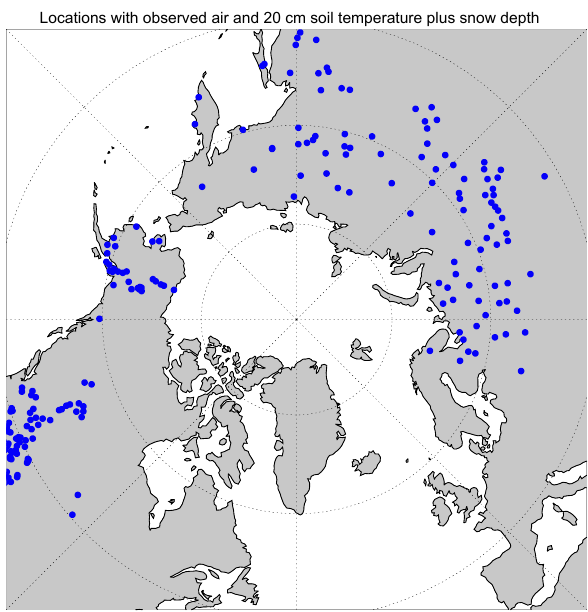
Figure 2. Locations with colocated observations of air temperature, 20cm soil temperature, and snow depth.